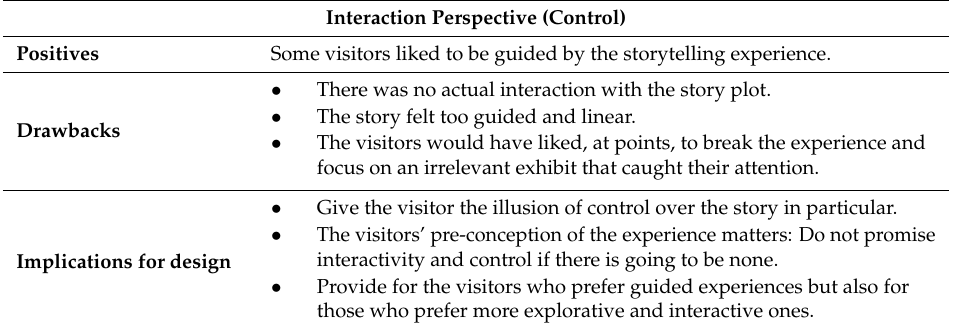
Table 6. Insights from findings on the interaction perspective, and implications for design.